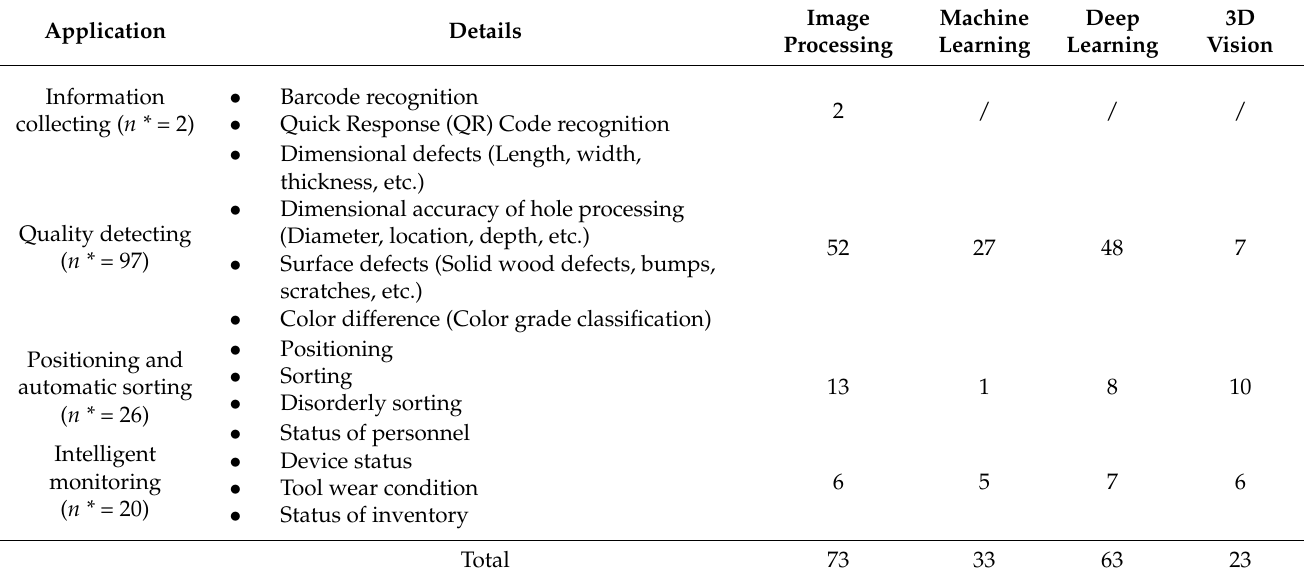
Table 1. The overview of the literature and key technologies.